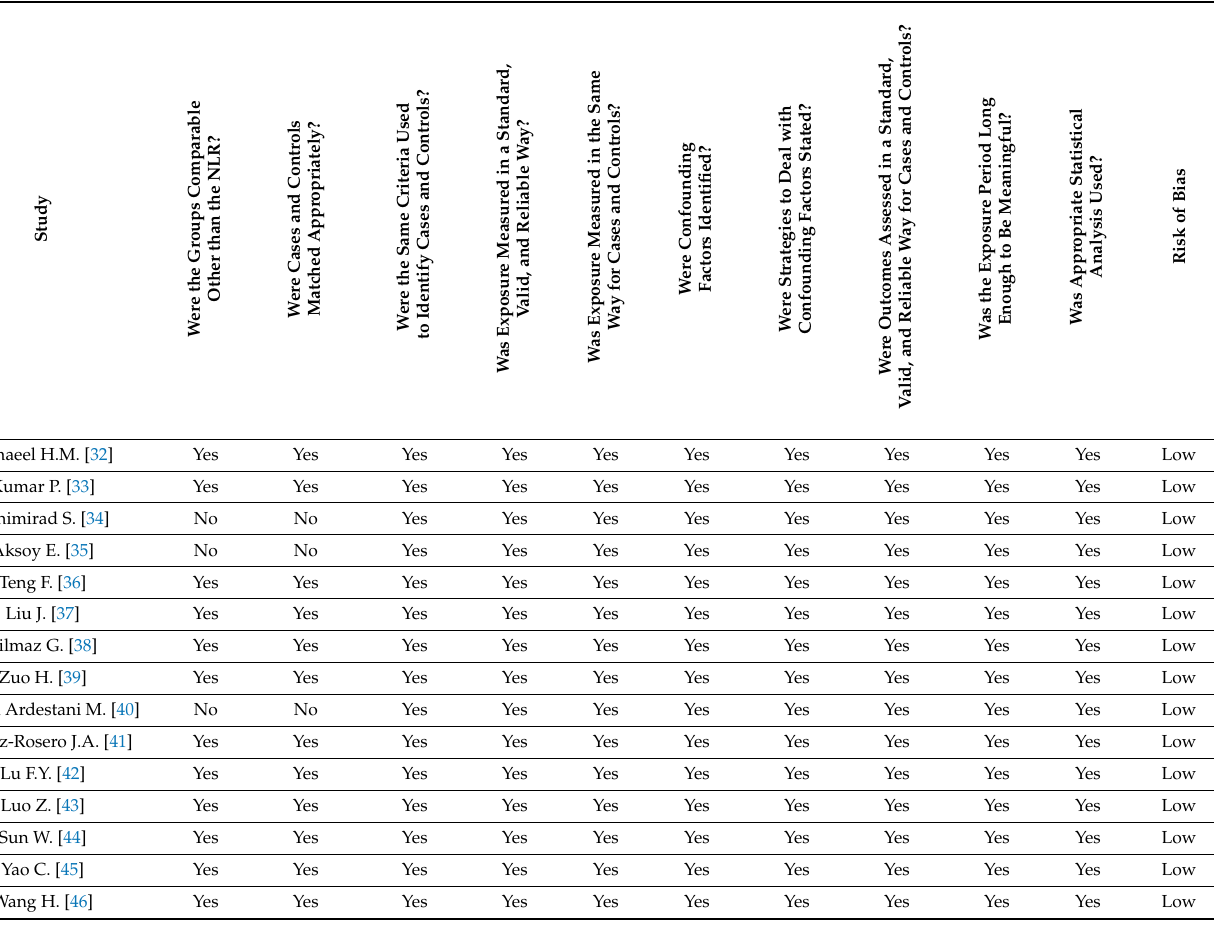
Table 2. The Joanna Briggs Institute Critical Appraisal